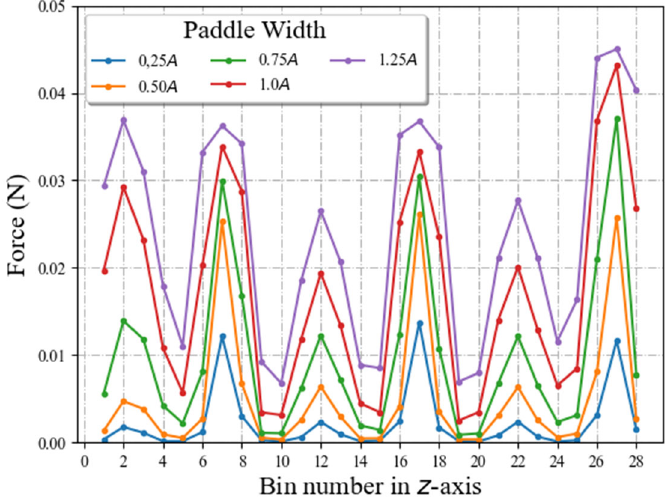
Figure 19. Time ‐ averaged forces acting on particles in a line along z ‐ direction for various paddle widths.